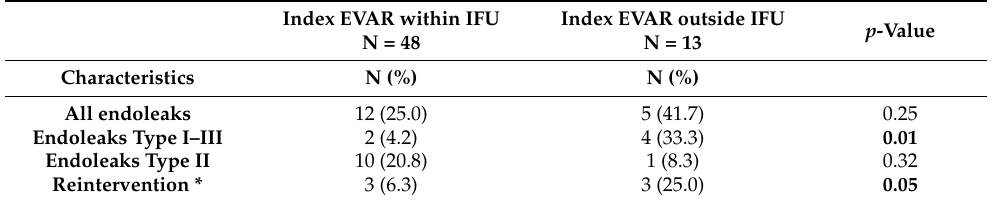
Table 3. Data concerning endoleaks and secondary interventions based on compliance with instruc- tions for use (IFU) in 60 patients undergoing EVAR for infrarenal aortic aneurysm. Index EVAR within IFU Index EVAR outside IFU N = 48 N = 13